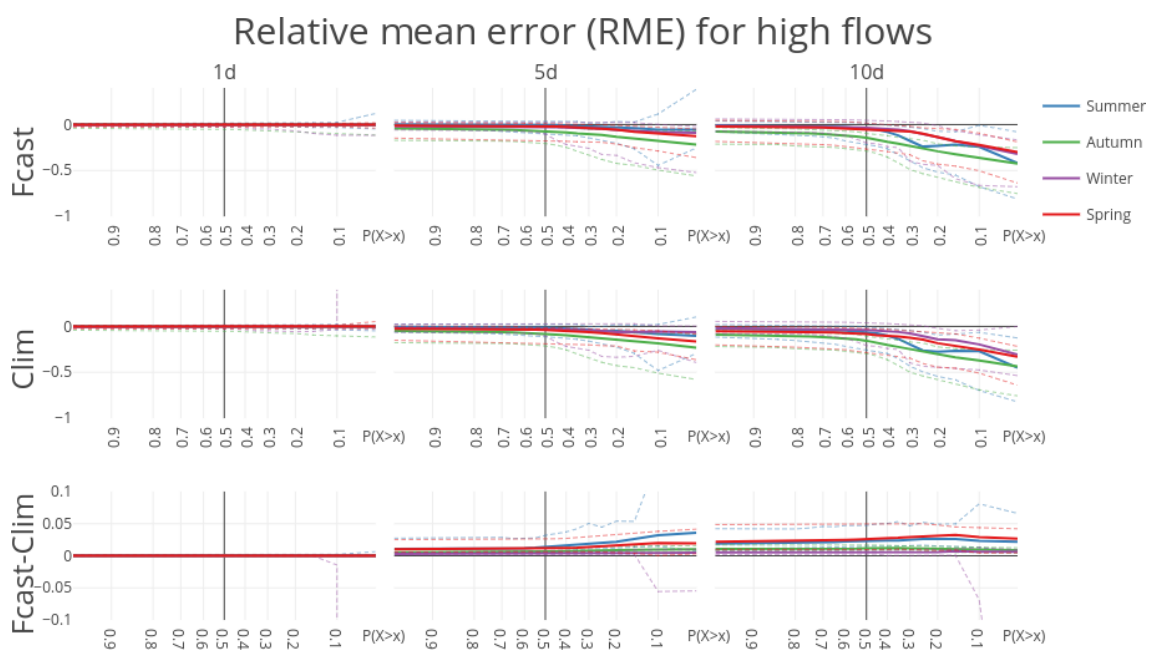
Figure 9. RME for forecast runs (forecasted PET, climatological PET) and their difference for the 20 largest streams in the Rhine basin. RME scores are aggregated into mean (solid), 10th and 90th percentiles (dashed). Note that the CRPSS at P(X ≥ x) = 0 . 1 or 0.7 is calculated over, respectively, the 10% and 70% highest observation–forecast pairs, conditioned on the